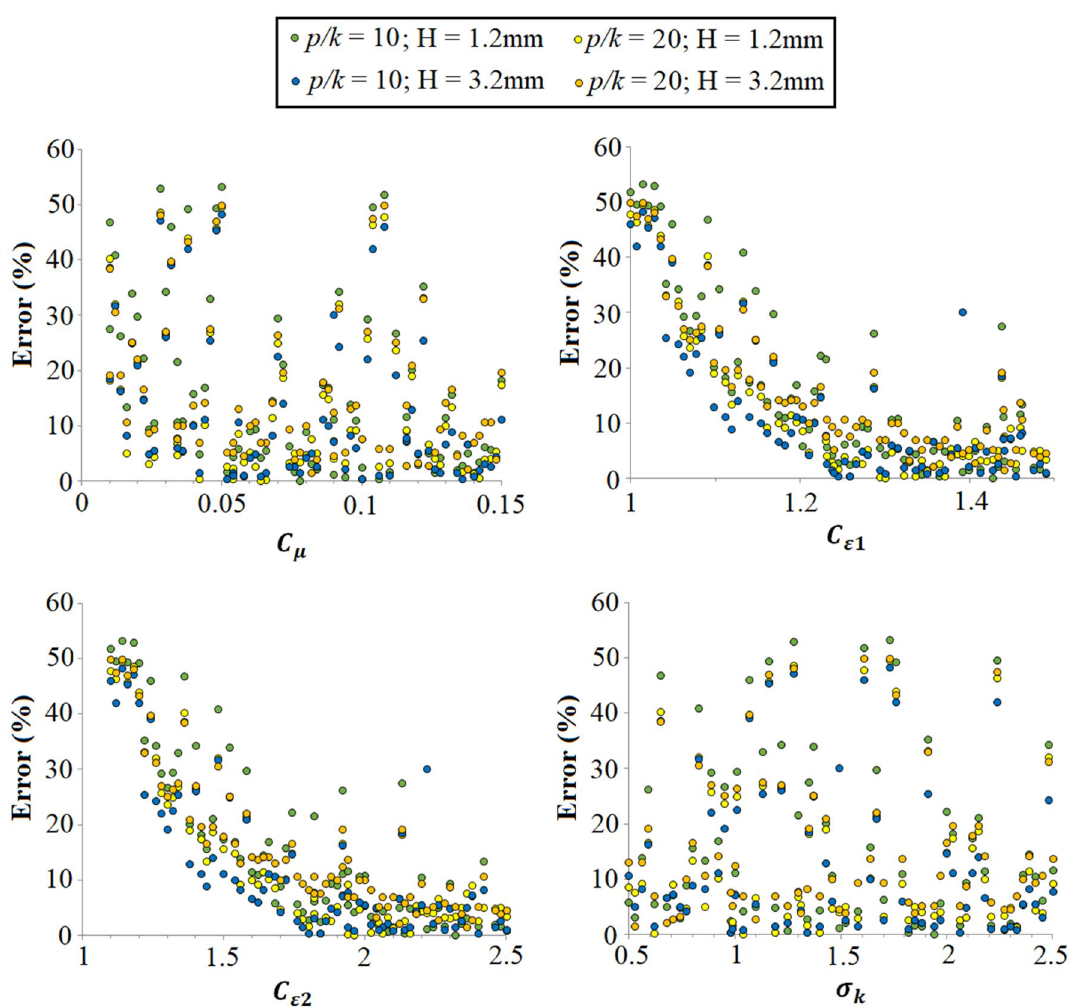
Fig. 11 Absolute values of relative errors in predicting the Nusselt number with κ-ε turbulent